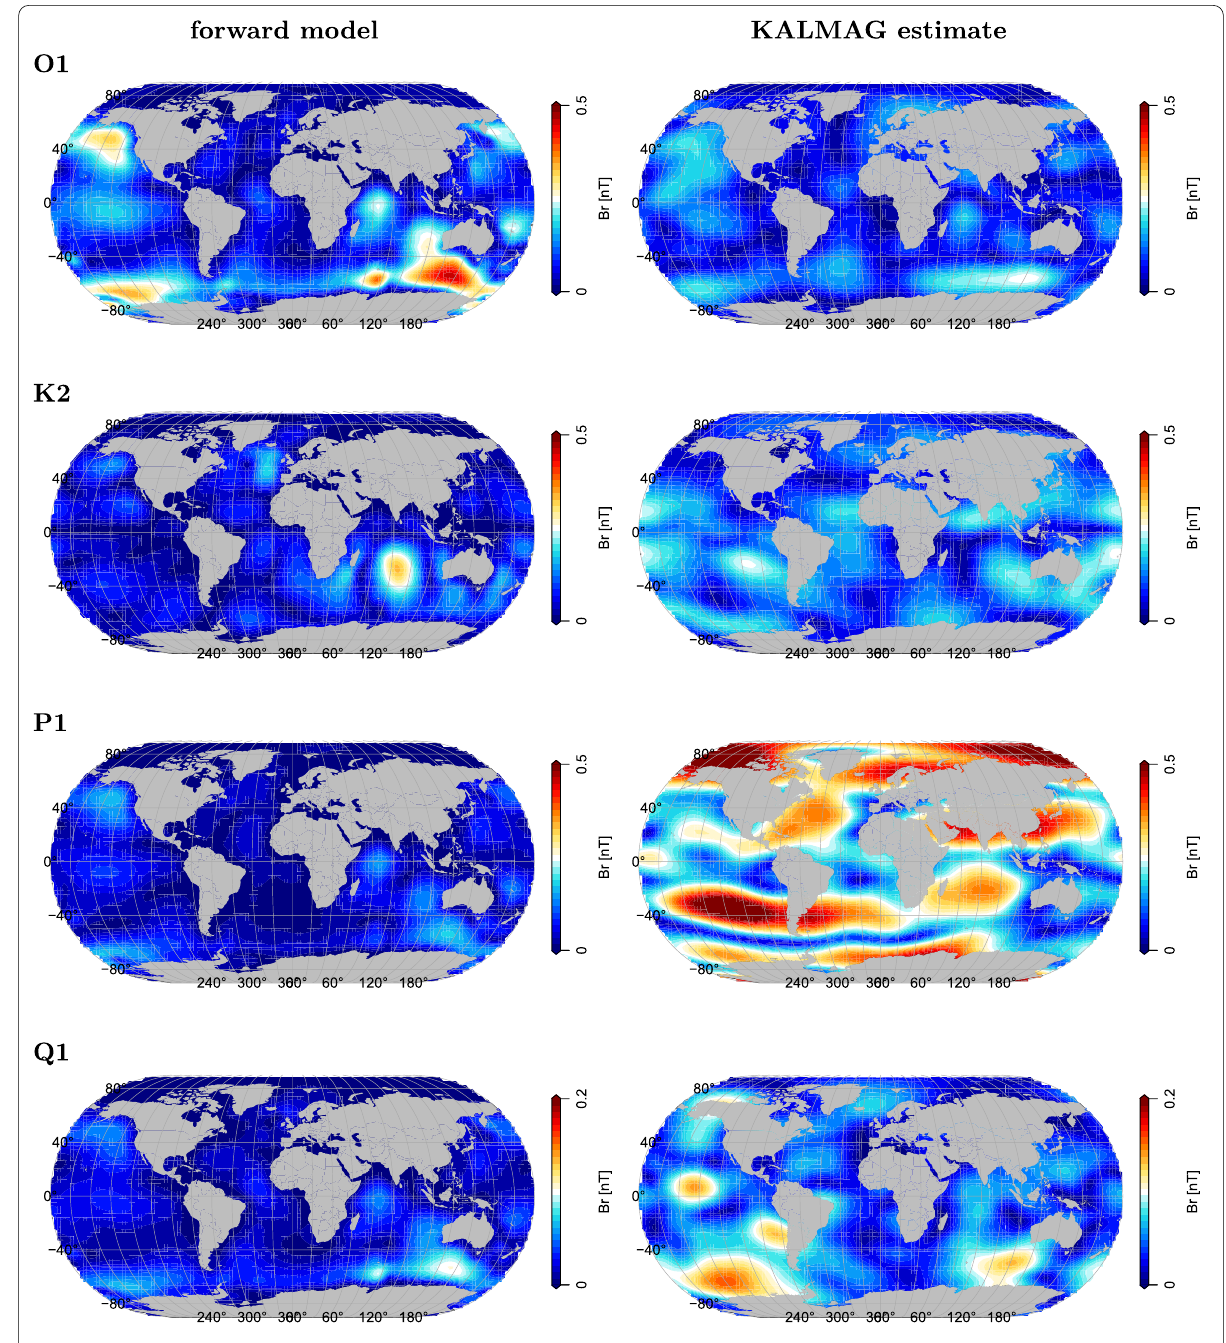
Fig. 2 Tidal radial magnetic fields (O1, K2, P1, Q1). Left column: results from forward modeling of ocean tides. Right column: results from KALMAG inversion of Swarm and CHAMP observations. All fields are represented at the satellite height of 430 km above sea level. Please note the different color bar